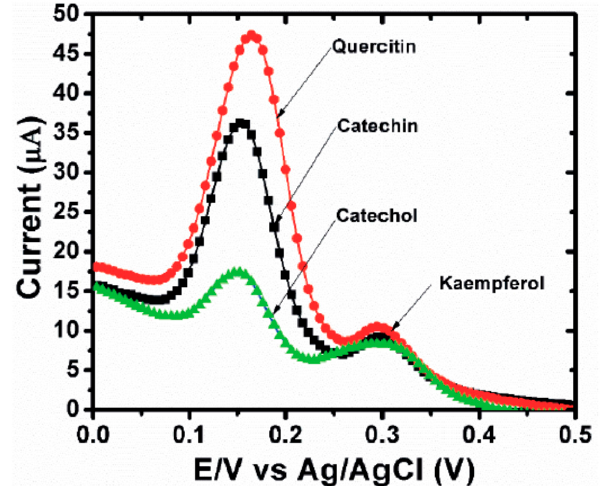
Figure 5. Mechanism of electrochemical oxidation of kaempferol at Fe 2 O 3 NPs / MWCNTs / GCE. ( i ): structure of kaempferol; ( ii ): cationic intermediate after the first electron loss; ( iii ): charge delocalization of the cationic intermediate; ( iv ): final oxidation product after the second electron loss. Reproduced under the terms of the CC-BY Creative Commons attribution 4.0 from Reference [54], Copyright 2019.